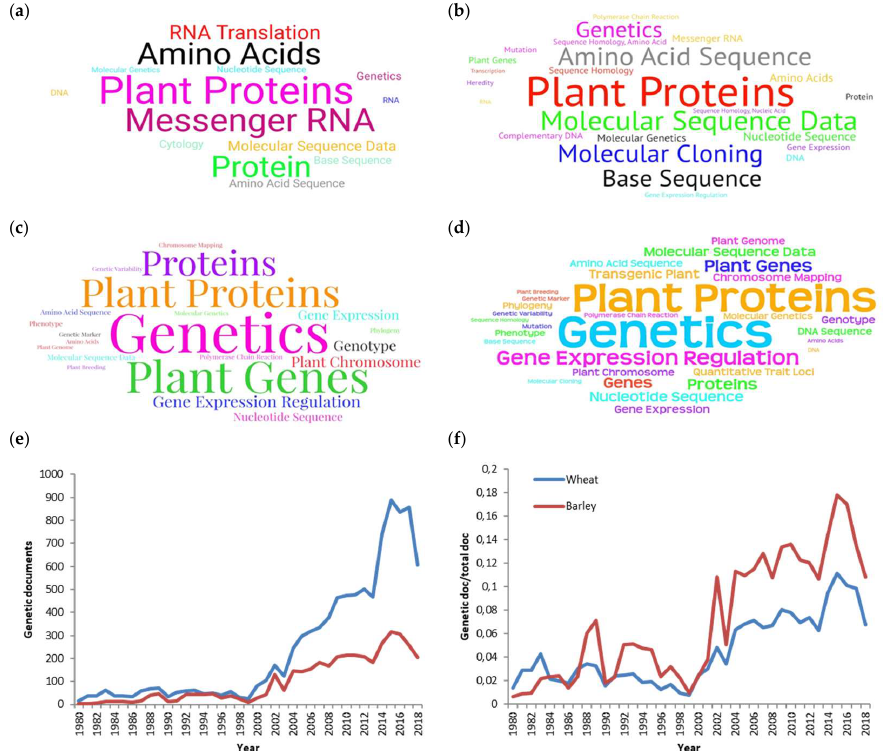
Figure 9. ( a – d ) Word cloud based on the main keywords related to genes and proteins in wheat ( a , c ) and barley ( b , d ) in worldwide research until ( a , b ) and from ( c , d ) the year 2000. e ) Number of genetics-